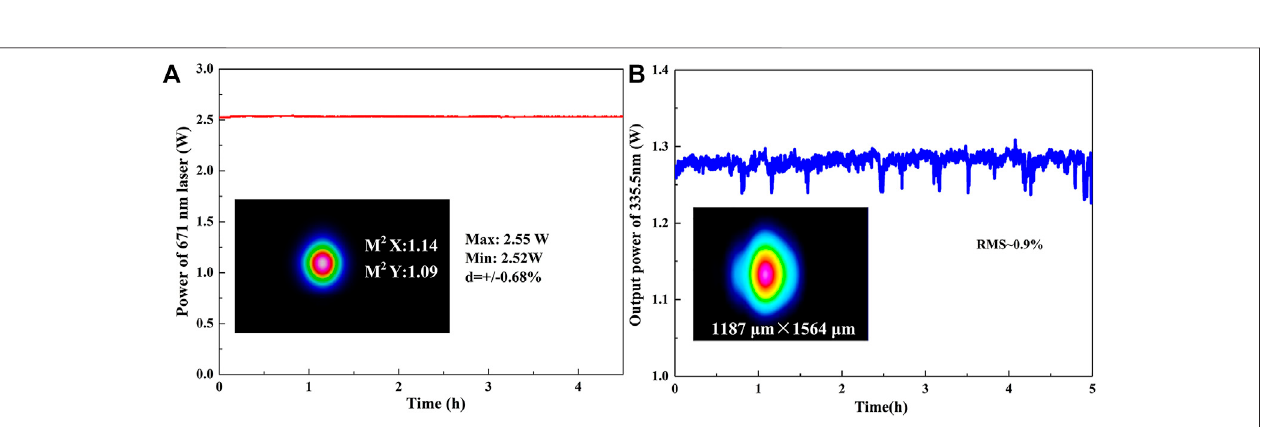
FIGURE2|(A) Stabilityoftheoutputpowerofthe671 nmlaser,theinset:beamquality. (B )Thestabilityofthe335.5 nmsingle-frequencylaser,theinset:thebeam pro fi